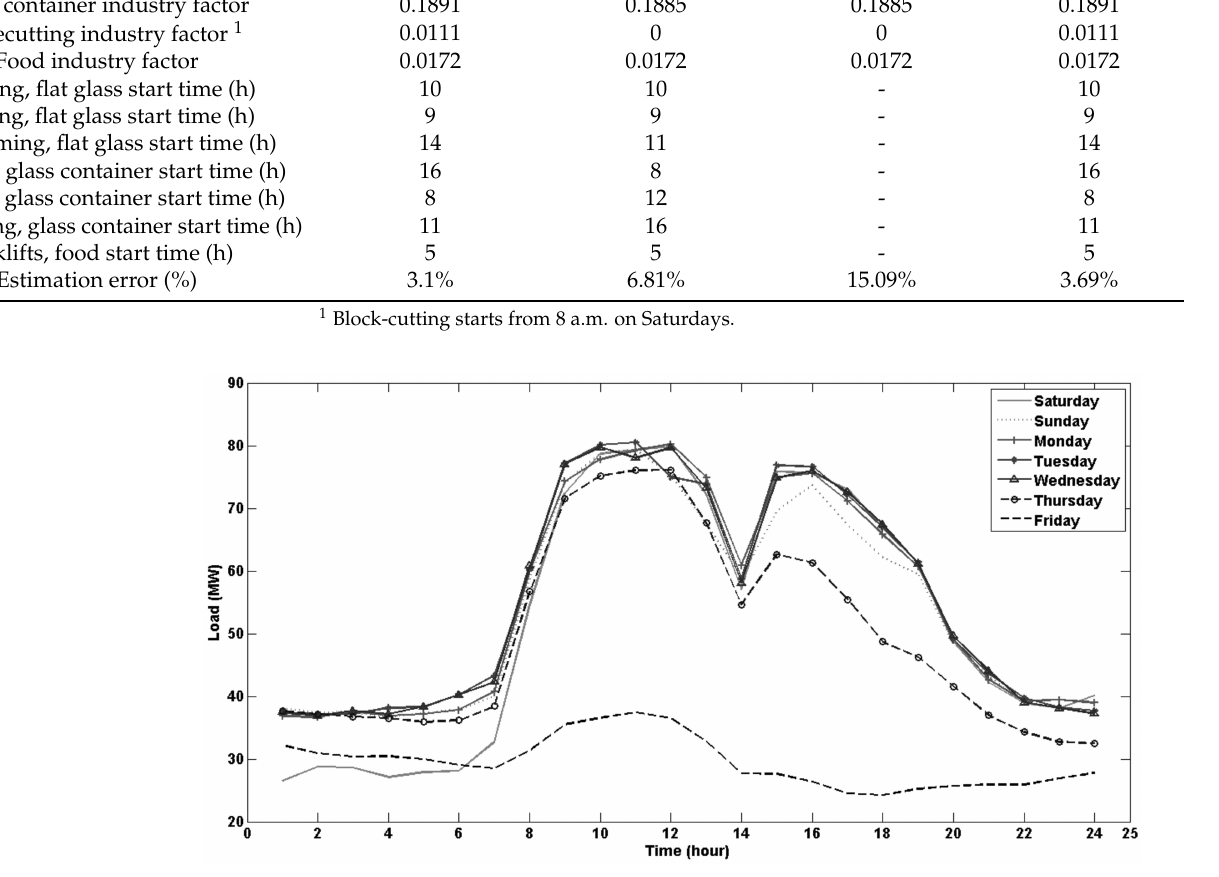
Figure 7. Hourly load curve of Shams Abad industrial zone in winter over a